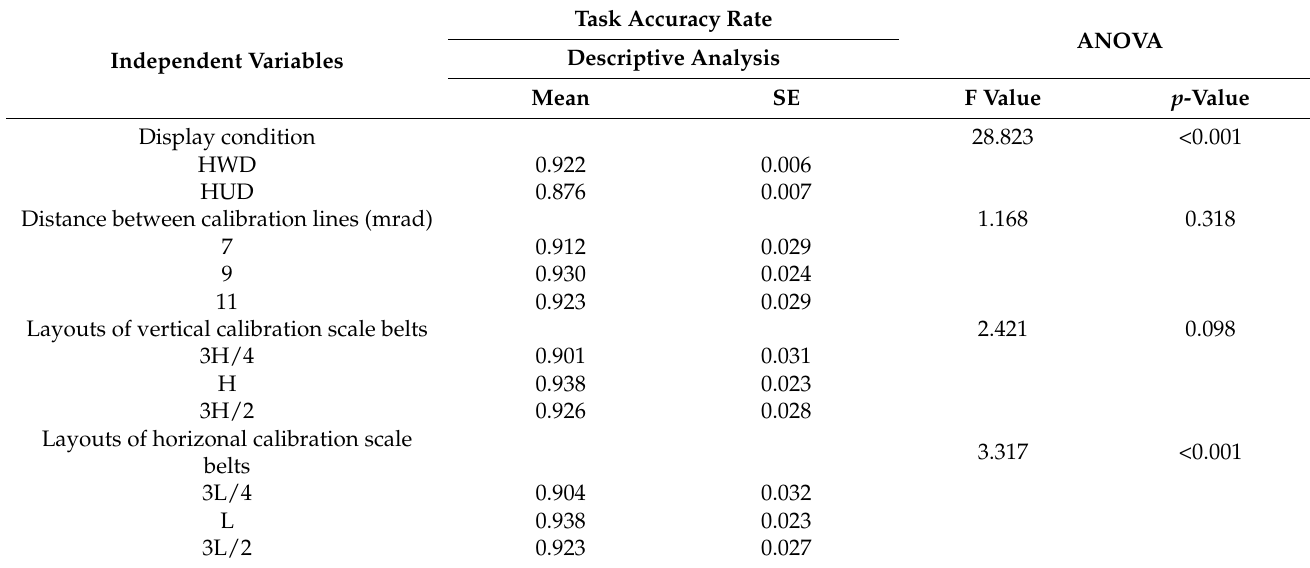
Table 3. Main effects of display condition, distance between calibration lines and layouts of vertical and horizonal calibration scale belts on task accuracy rate.